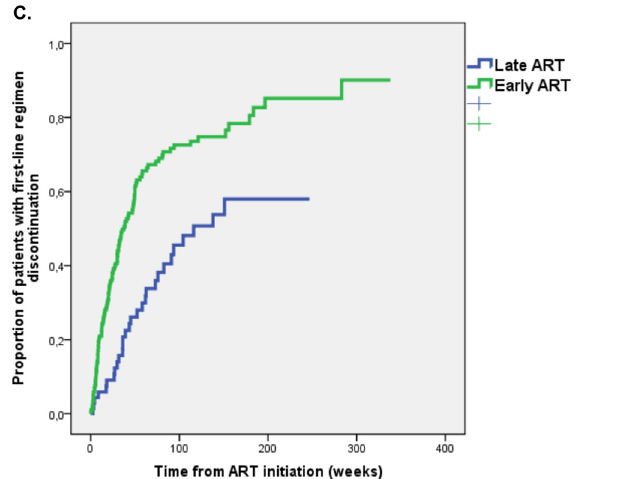
Figure 1. Kaplan Meier estimates of time to (A) optimal immunological recovery, (B) virological suppres- sion and (C) first-line regimen discontinuation in Early versus Late ART group. We evaluated predictors of time to optimal immunological recovery by Cox regression analysis (Table 3). At multivariate analysis, early ART (HR 1.84 [95% CI 1.04-3.27], P = 0.036) confirmed an independent association with a higher probability of optimal immunological recovery after adjustment for Fiebig stage, the first ART regimen including > 3 drugs, calendar year, and baseline immunological status (ie, absolute and percentage CD4 count, CD4/CD8